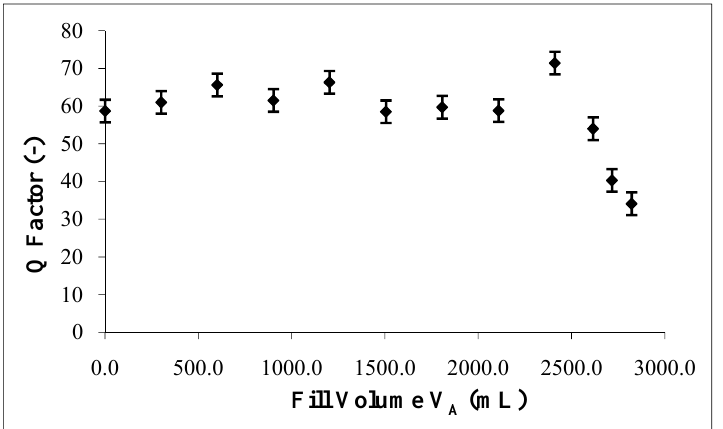
Figure 6. Q factor with increasing water fill level, measured using 3 L chamber, 170 mm long, and 44 mm diameter